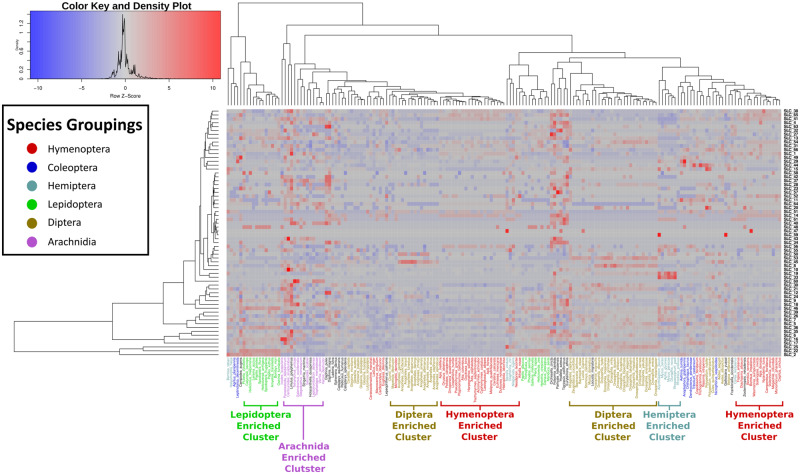
Clustering of species by SLC count. Species (x-axis) were hierarchically clustered based on their SLC family sizes (y-axis) in order to see whether evolutionarily related species showed similar SLC profiles. Species are color coded according to their taxonomic group (blue, Tribolium; red, Hymenoptera; brown, Diptera; magenta, Hemiptera; purple, Arachnida; green, Lepidoptera; black, other). Boxes toward the red end of the spectrum have a relatively large family, whereas bluer boxes have lower copy numbers. Many related species cluster closely together, but other areas of the graph are relatively diverse in terms of their composition.